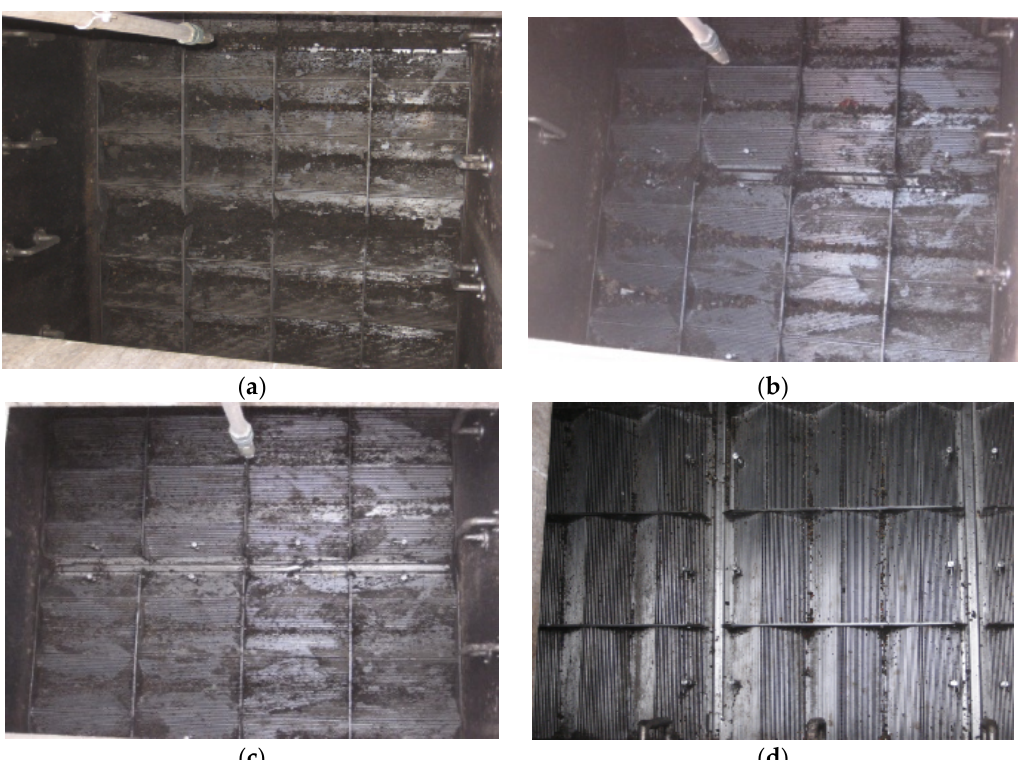
Figure 8. Phase 1: CSO screen conditions on site 2 in West Yorkshire. ( a ) Unclean condition; ( b ) first level of cleaning; ( c ) second level of cleaning; ( d ) fully clean.